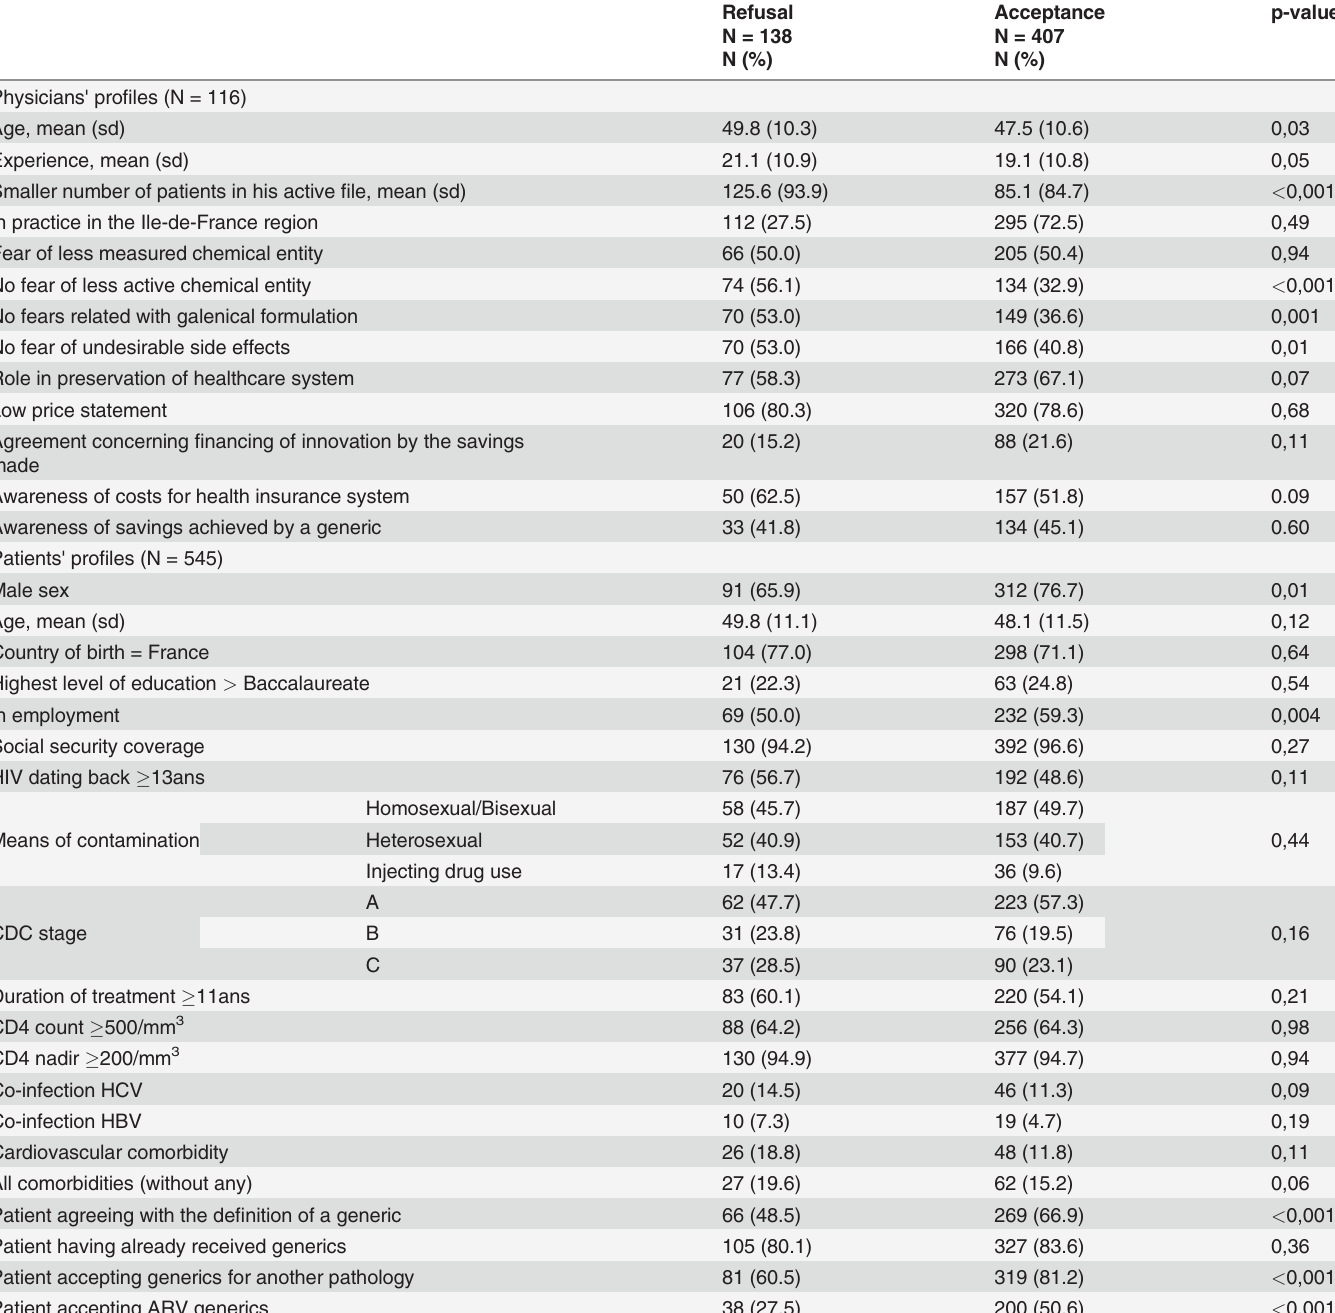
Table 4. Factors associated with prescription of ARV generics by